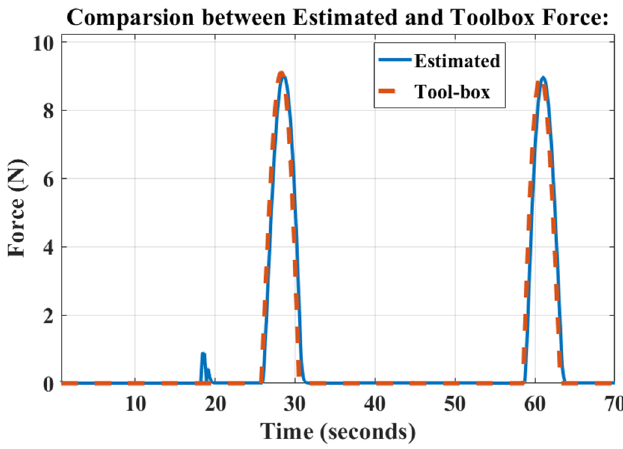
Figure 12. Estimated force vs. force provided by toolbox.